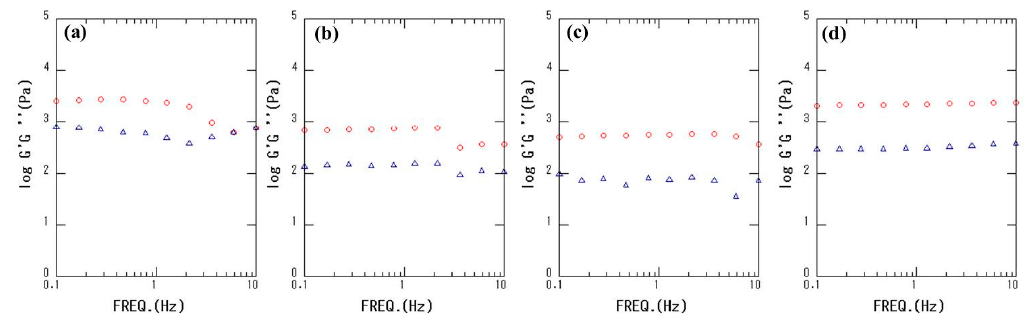
Figure 3. XRD profiles of products by lyophilization of run 2 with reaction times of ( a – d ) 0.5, 1, 3, and 5.